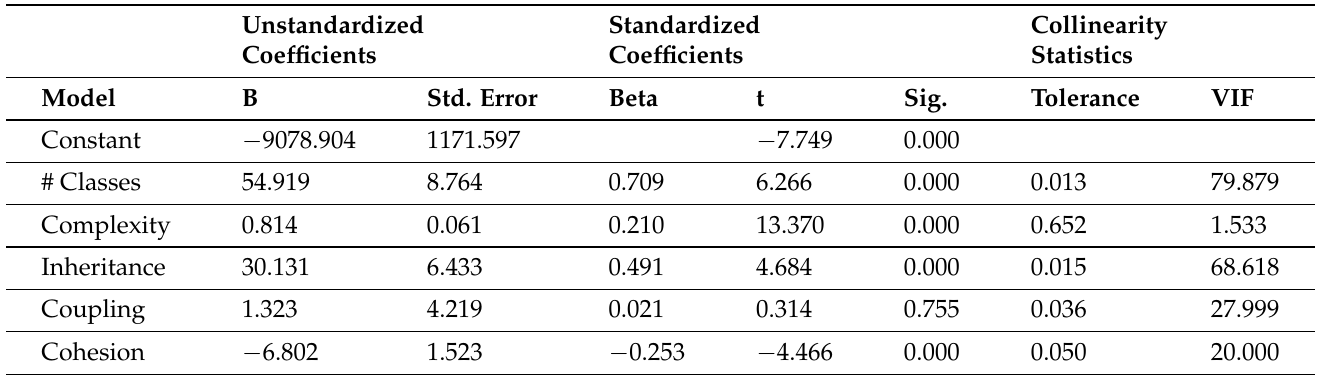
Table 4. Regression Analysis.